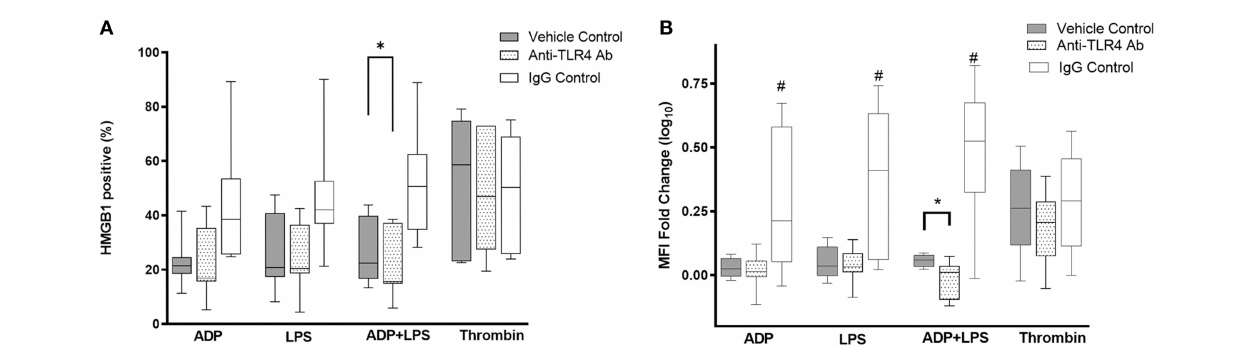
FIGURE 4 | LPS-mediated HMGB1 expression is dependent on platelet TLR4. Washed platelets from eight dogs were treated with function blocking antibodies, an isotype control or vehicle control prior to activation with 10 µ M ADP, 5 µ g/ml LPS, 0.01 U/ml thrombin or LPS in the presence of ADP. HMGB1 surface expression, measured by flow cytometry, was expressed as (A) percent (%) positive cells or (B) median fluorescence intensity (MFI) fold change on a log 10 scale. TLR4 inhibition modulated LPS-mediated HMGB1 expression in platelets primed with ADP. Each line represents the median while the box represents the 25th and 75th percentile. Whiskers represent the range. One-way repeated measures ANOVA was used to assess the effect of TLR4 inhibition on HMGB1 expression separately in ADP, ADP + LPS or thrombin activated platelets, followed by post-hoc analysis by Dunnett’s multiple comparisons. * p < 0.05, # p <